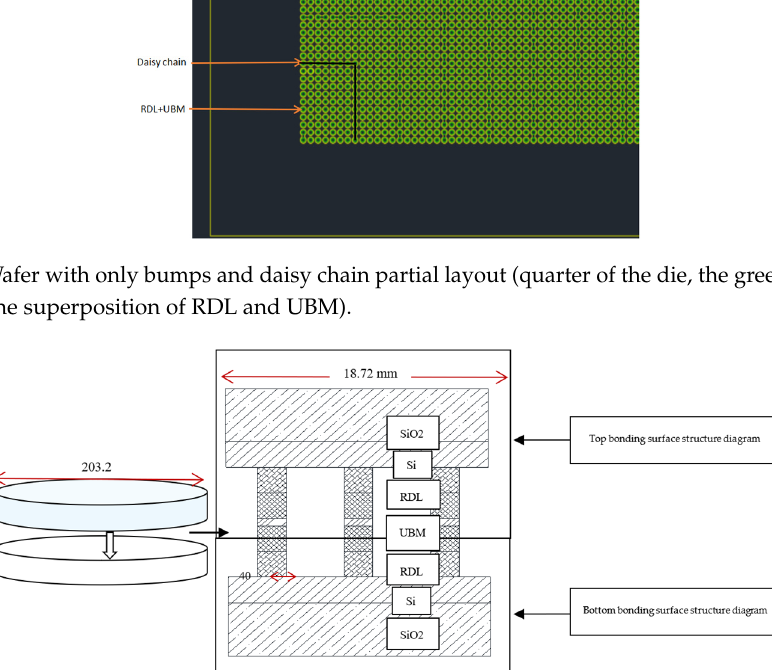
Figure 3. Schematic diagram of the structure after bonding.